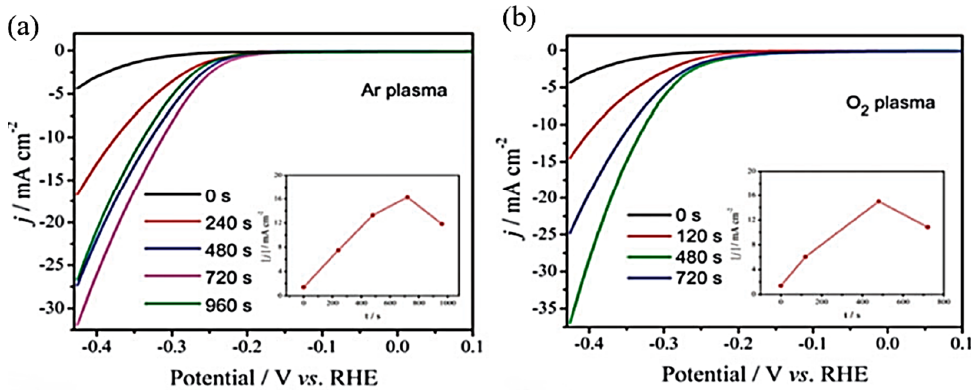
Figure 7. The polarization curves of the MoS 2 thin films at a 2 mV s −1 scan rate after different ( a ) Ar plasma and ( b ) O 2 plasma treatment times [43].